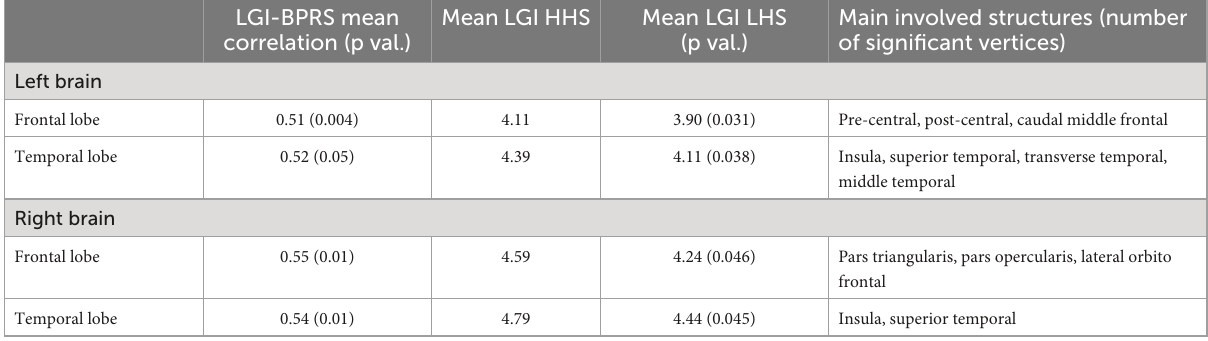
TABLE 3 LGI-BPRS correlation, between-group differences.